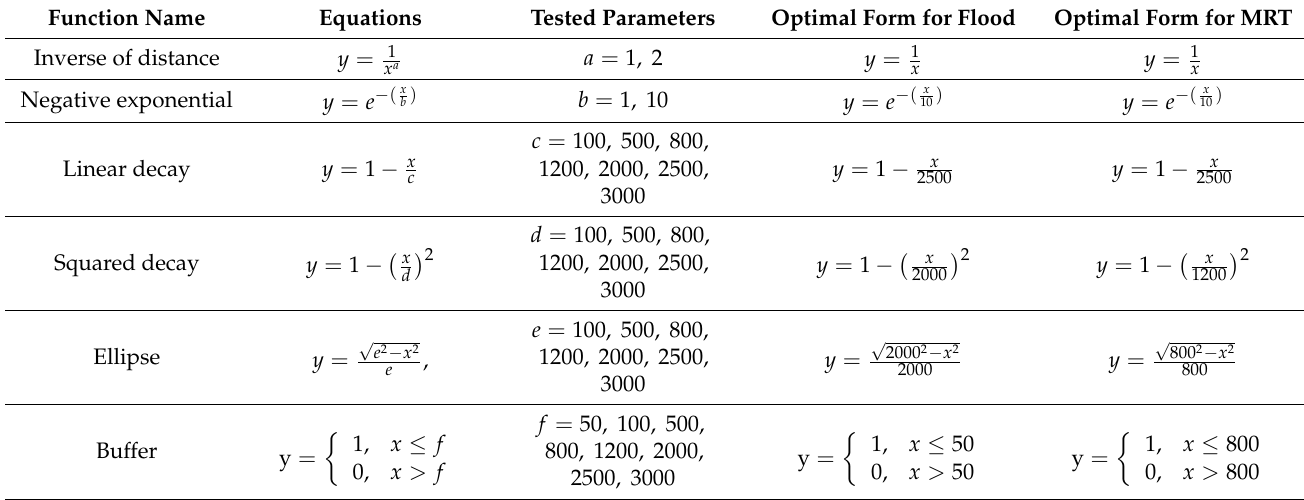
Table 4. Optimal functions and parameters used in this